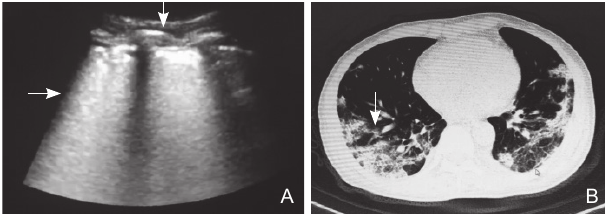
Figure 1 Severe COVID-19 ultrasound and CT images. (A) image of the cross section in the back BLUE spot, and the small arrow pointed at the fused B-line (white screen). The arrow indicates a discontinuous and interrupted pleura; (B) the arrows pointed at a honeycomb-like lung, more prominent at the basal segment of the lung.